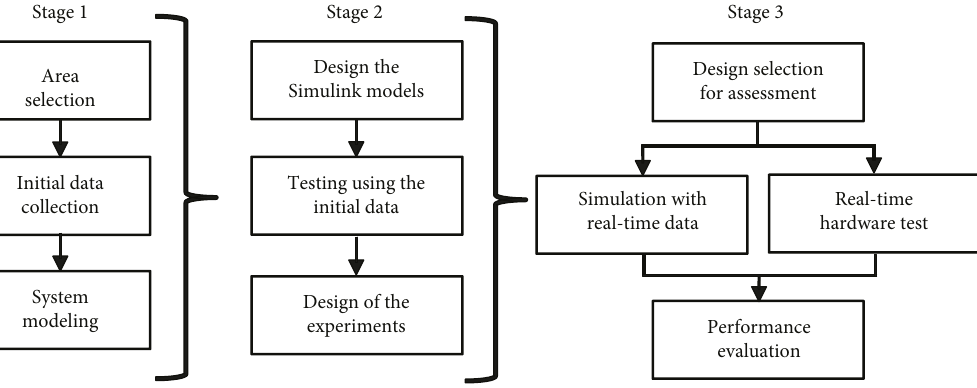
Figure 1: Schematic overview of the paper.